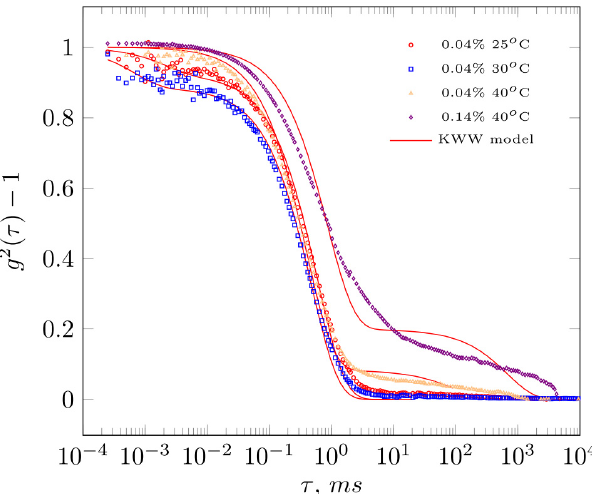
Figure 2. Reduced osmotic pressure as a function of extract concentration at selected temperatures.